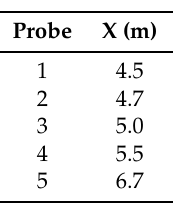
Table 3. Surface elevation gauge positions.